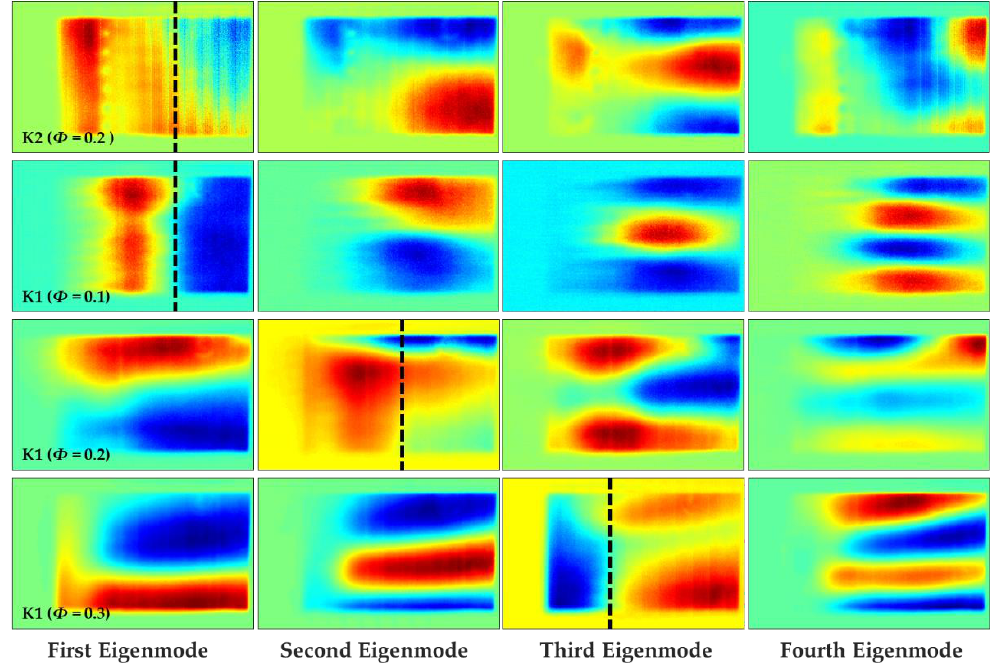
Figure 6. The first four POD modes of chemiluminescence images captured by FBE2.